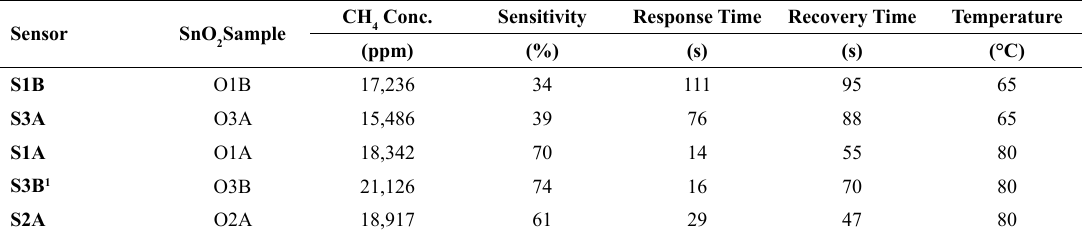
Figure 9. Electrical resistance versus time for CO Table 3. Performance of the different sensors exposed to ~20,000 ppm CH